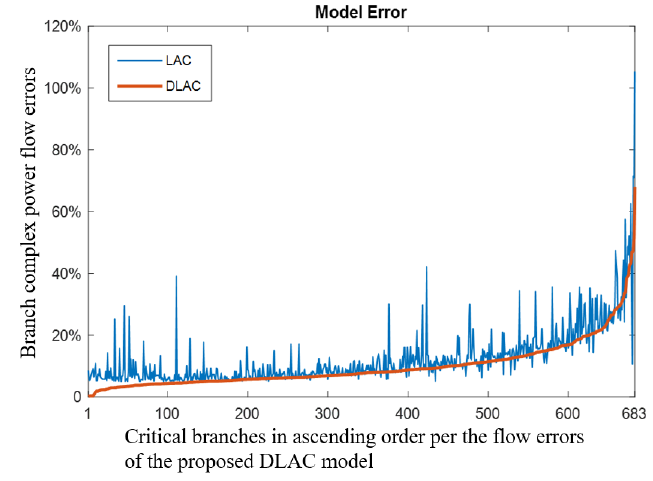
Figure 4. Branch complex power flow errors of LAC model and DLAC model for hour 1 case .